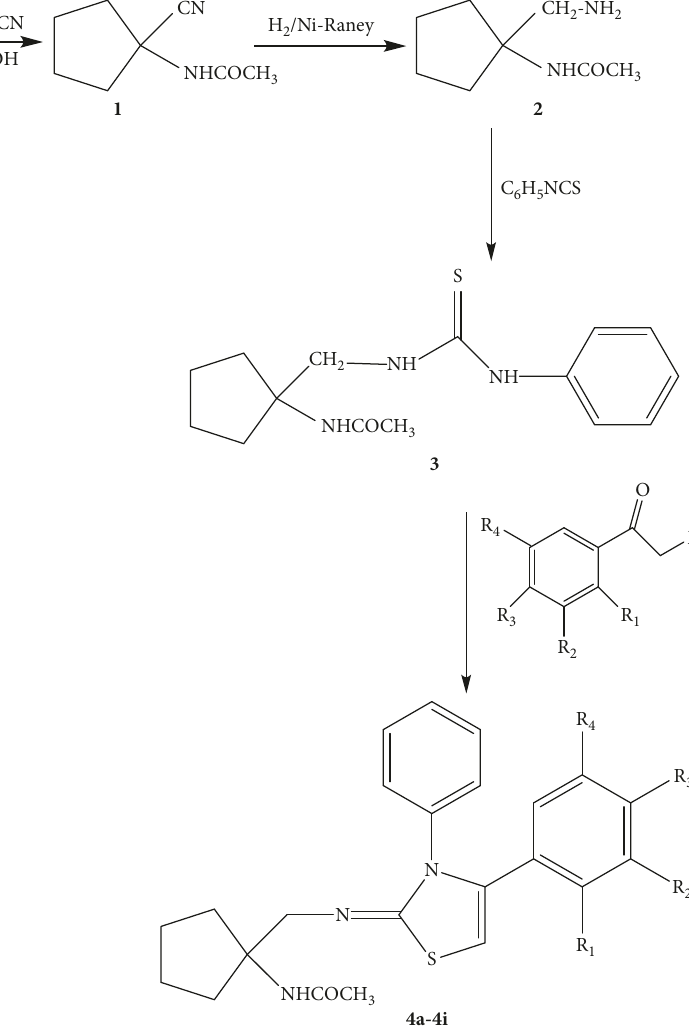
Scheme 1: Synthesis pathway of targeted compounds. Table 1: Newly synthesized compounds ( 4a-4i